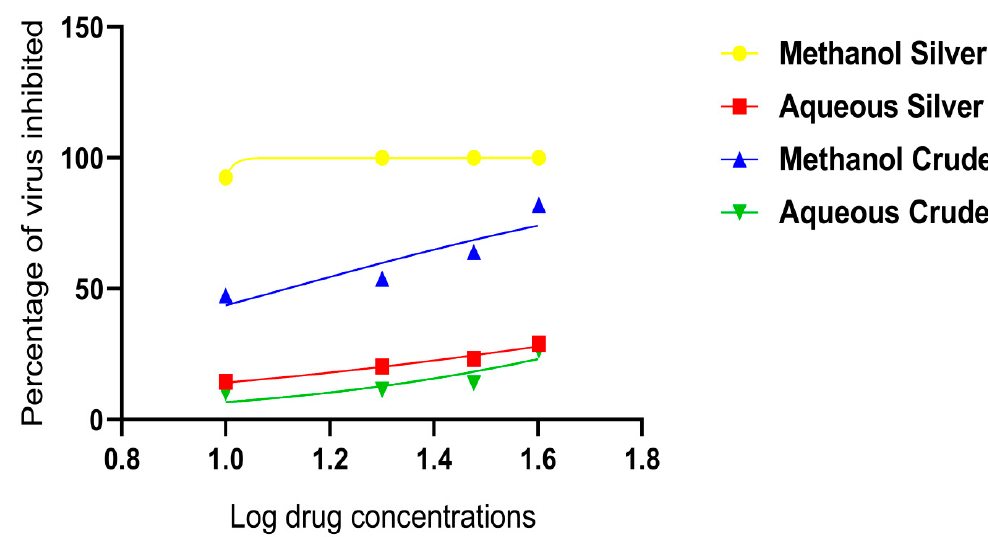
Figure 6. Percentage inhibition of the different C. papaya leaf extracts against cultured dengue virus type 2. Statistical analysis at a p < 0.05 showed that the percentage of inhibition of the extracts silver synthesized nanoparticles against dengue virus type 2 was significantly different from the crude extracts viral percentage inhibition. A similar observation was also made for the aqueous and the methanolic extracts (Figure 7).